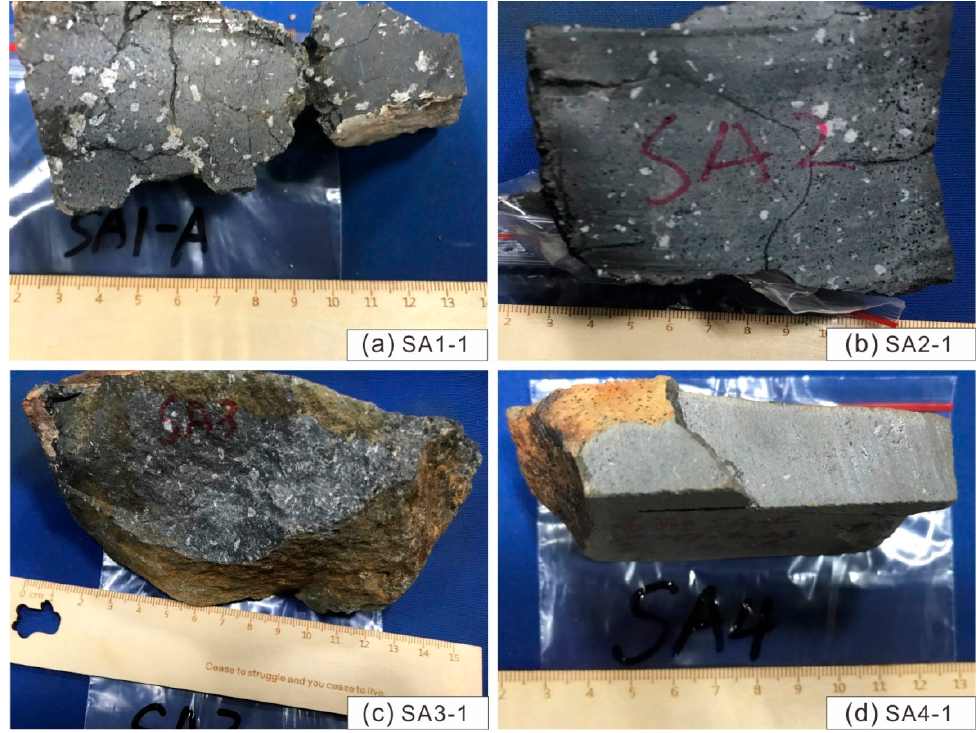
Figure 2. Hand specimen photographs of the South Mid-Atlantic Ridge (SMAR) basalt samples. ( a ) SA1-1; ( b ) SA2-1; ( c ) SA3-1; ( d )